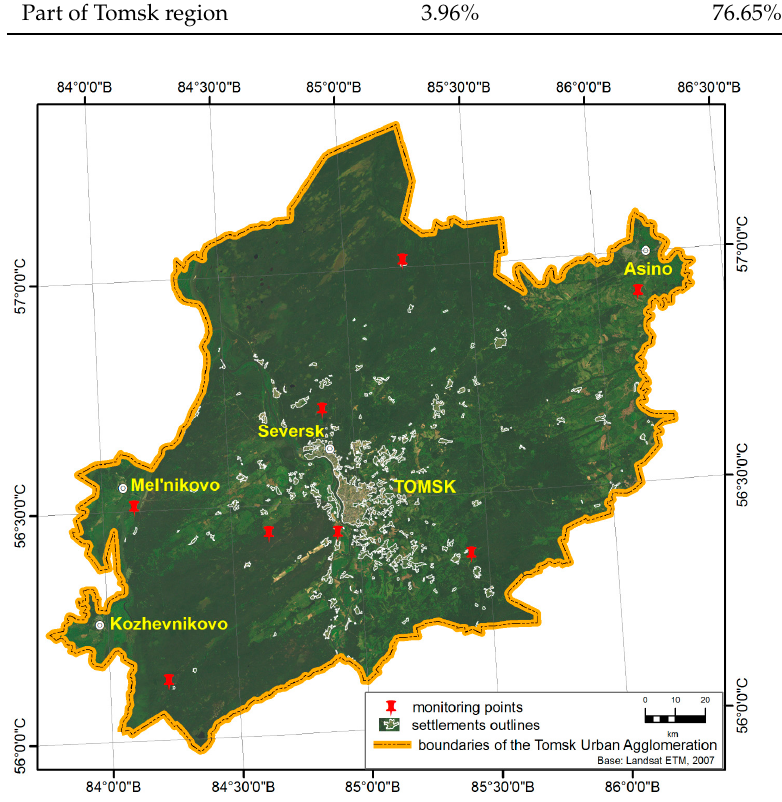
Figure 1. The study area of Tomsk agglomeration.